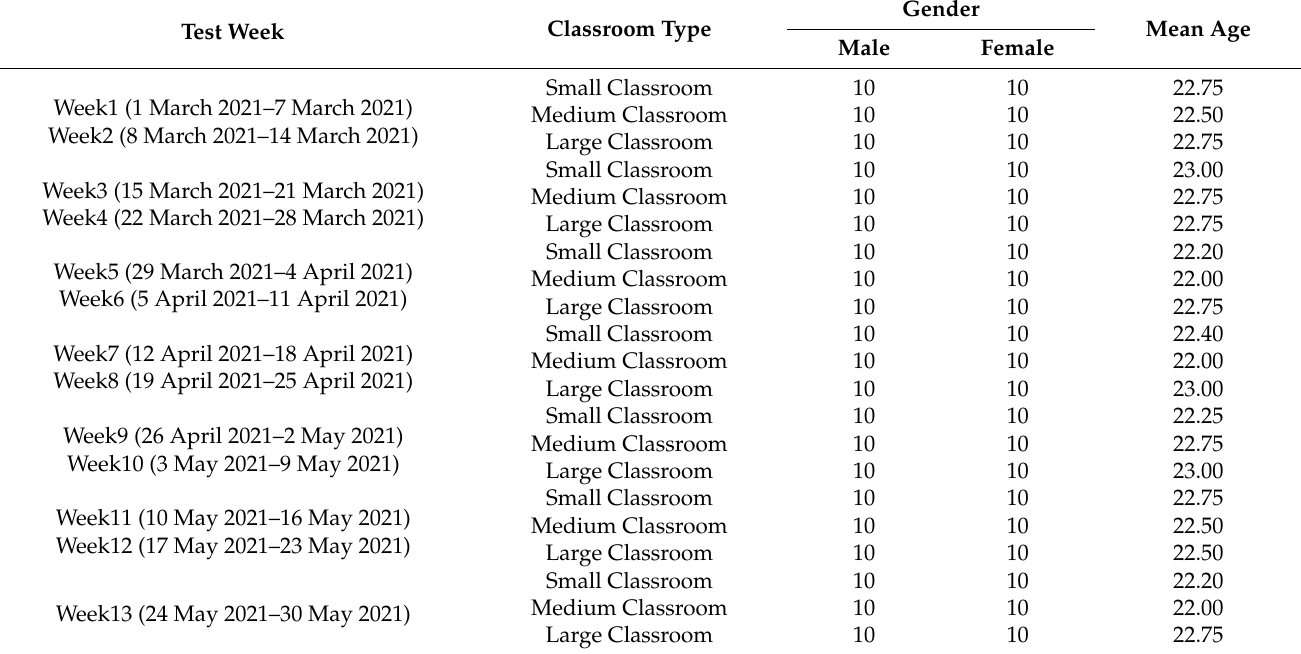
Table A1. Basic information of the tested students.